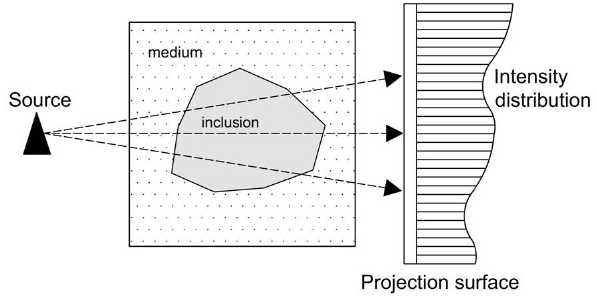
Figure 1. Intensity Distribution of an X-ray array.